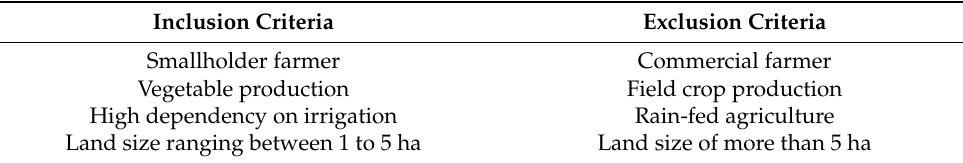
Table 4. Inclusion and exclusion criteria for survey selection.